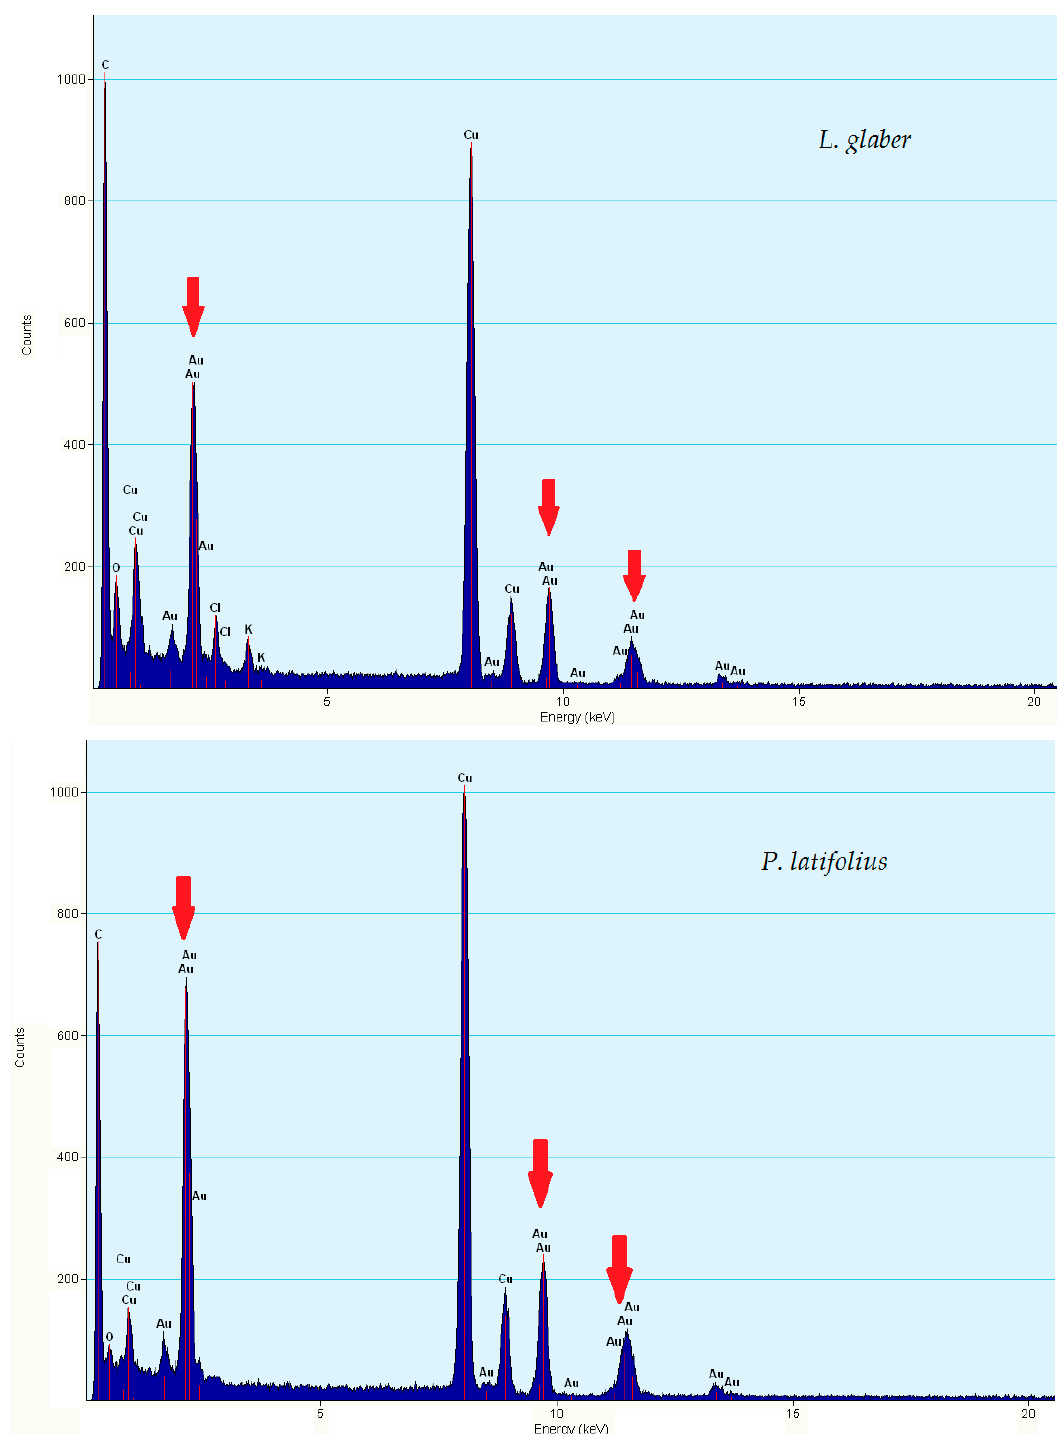
Figure 5. Energy Dispersive X-ray Spectroscopy (EDX) spectra of AuNPs from the extracts of L. glaber and P. latifolius . The red arrows show Au peaks. and P. latifolius . The red arrows show Au